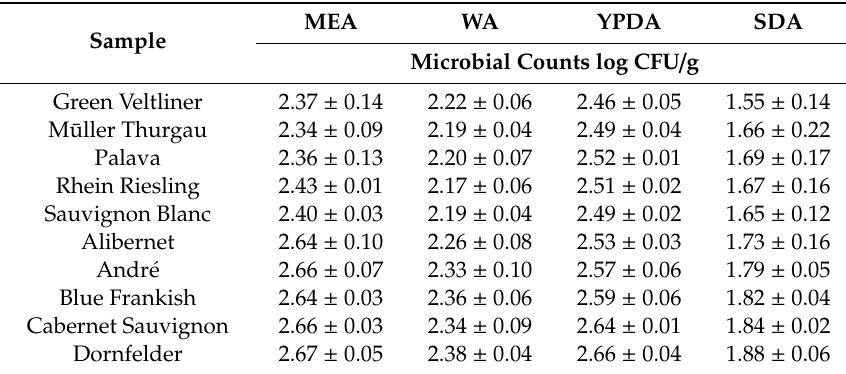
Table 1. Yeasts counts in grape berries on di ff erent